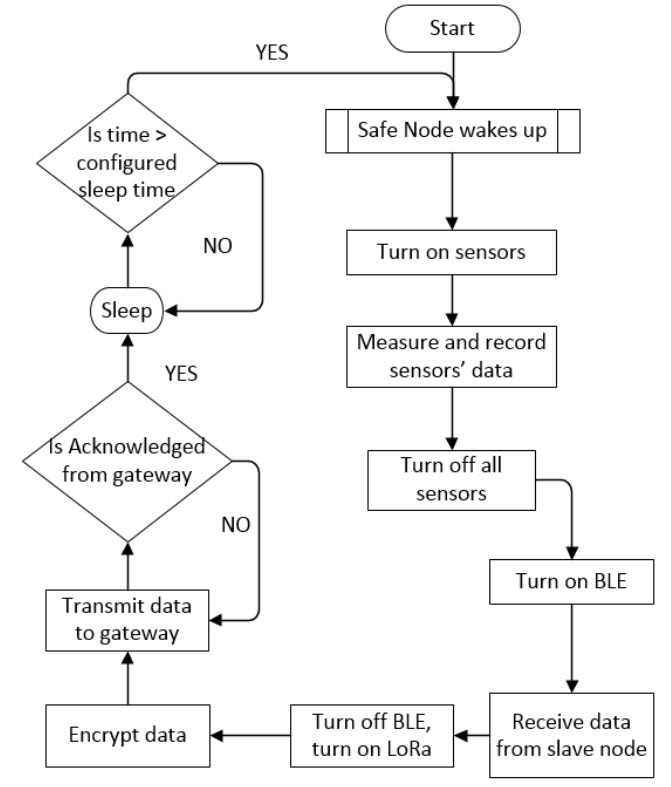
Figure 5. Software flowchart of the Safe Node.